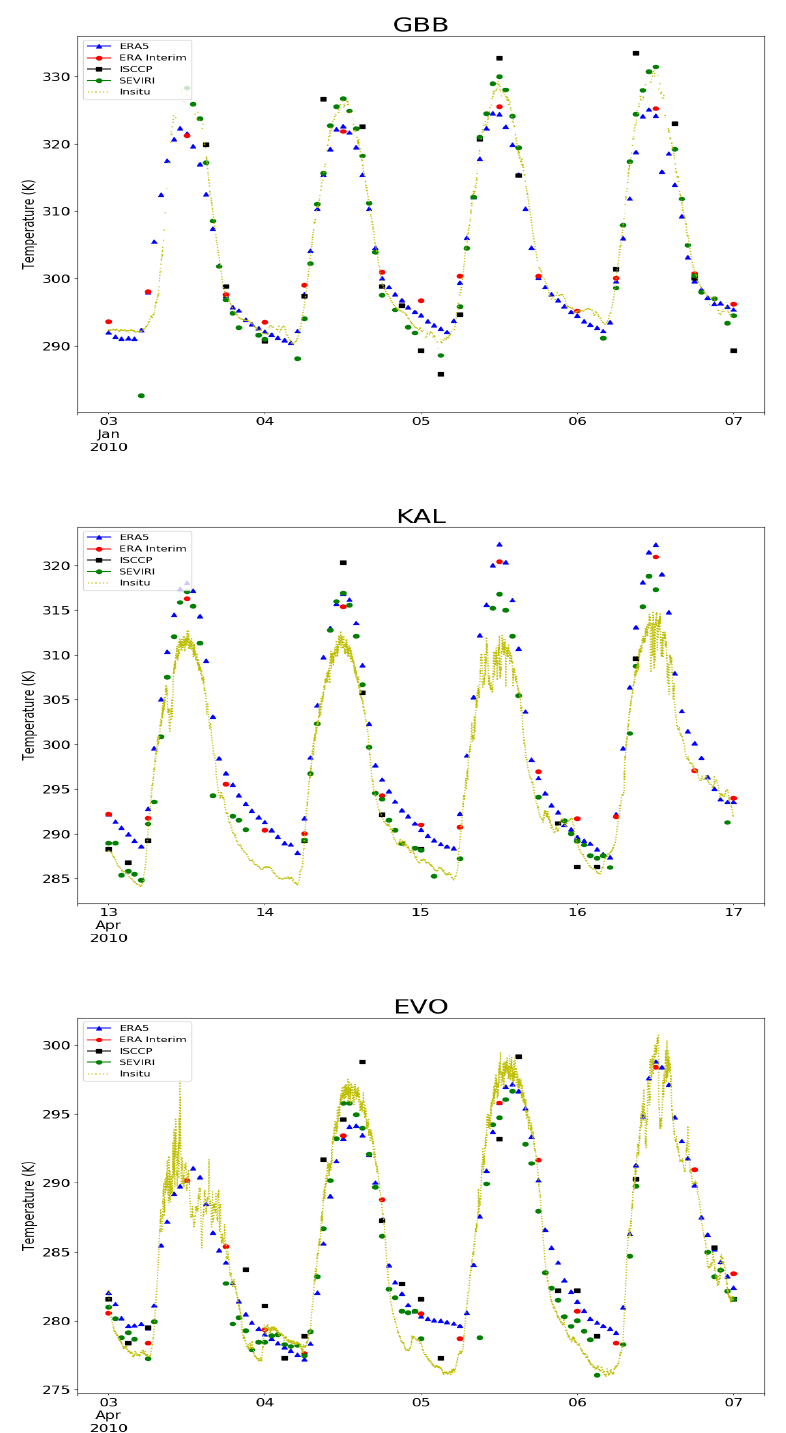
Figure 7. Example observations at GBB, KAL and EVO from ERA5, ERA Interim, ISCCP, SEVIRI, and in situ respectively in 2010.